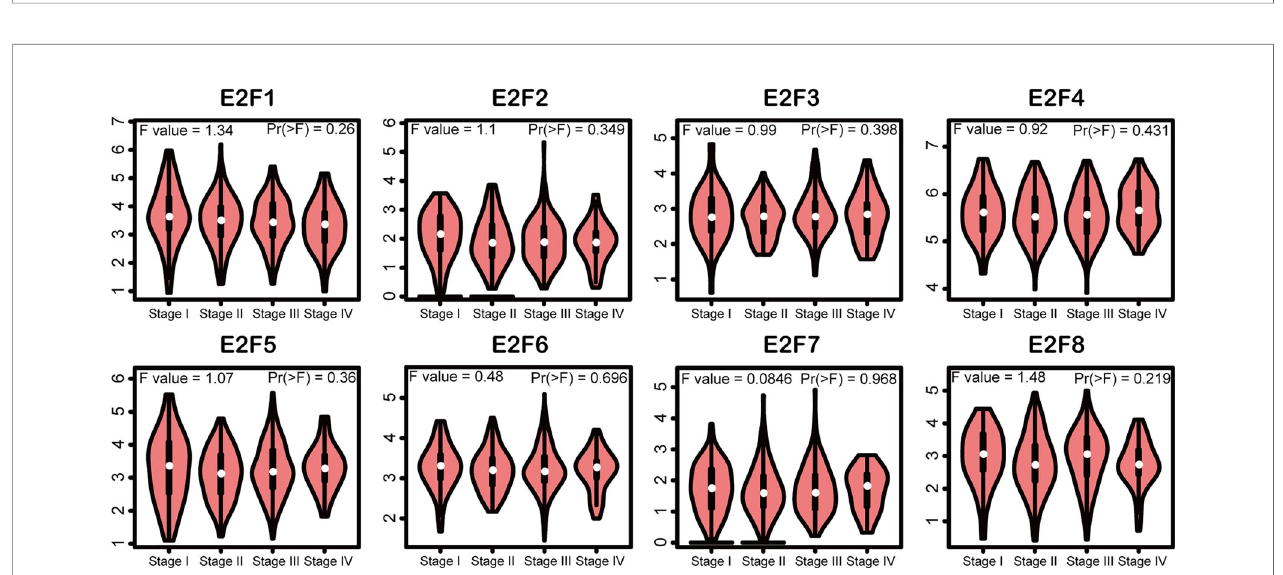
FIGURE 4 | Association of mRNA expression of E2Fs with tumor stages of STAD patients (GEPIA2). Violin plots depicted the differences of mRNA level of E2Fs across STAD tumor stage. The statistical signi fi cance was examined using one-way analysis of variance (ANOVA). The signi fi cance threshold was set at p <